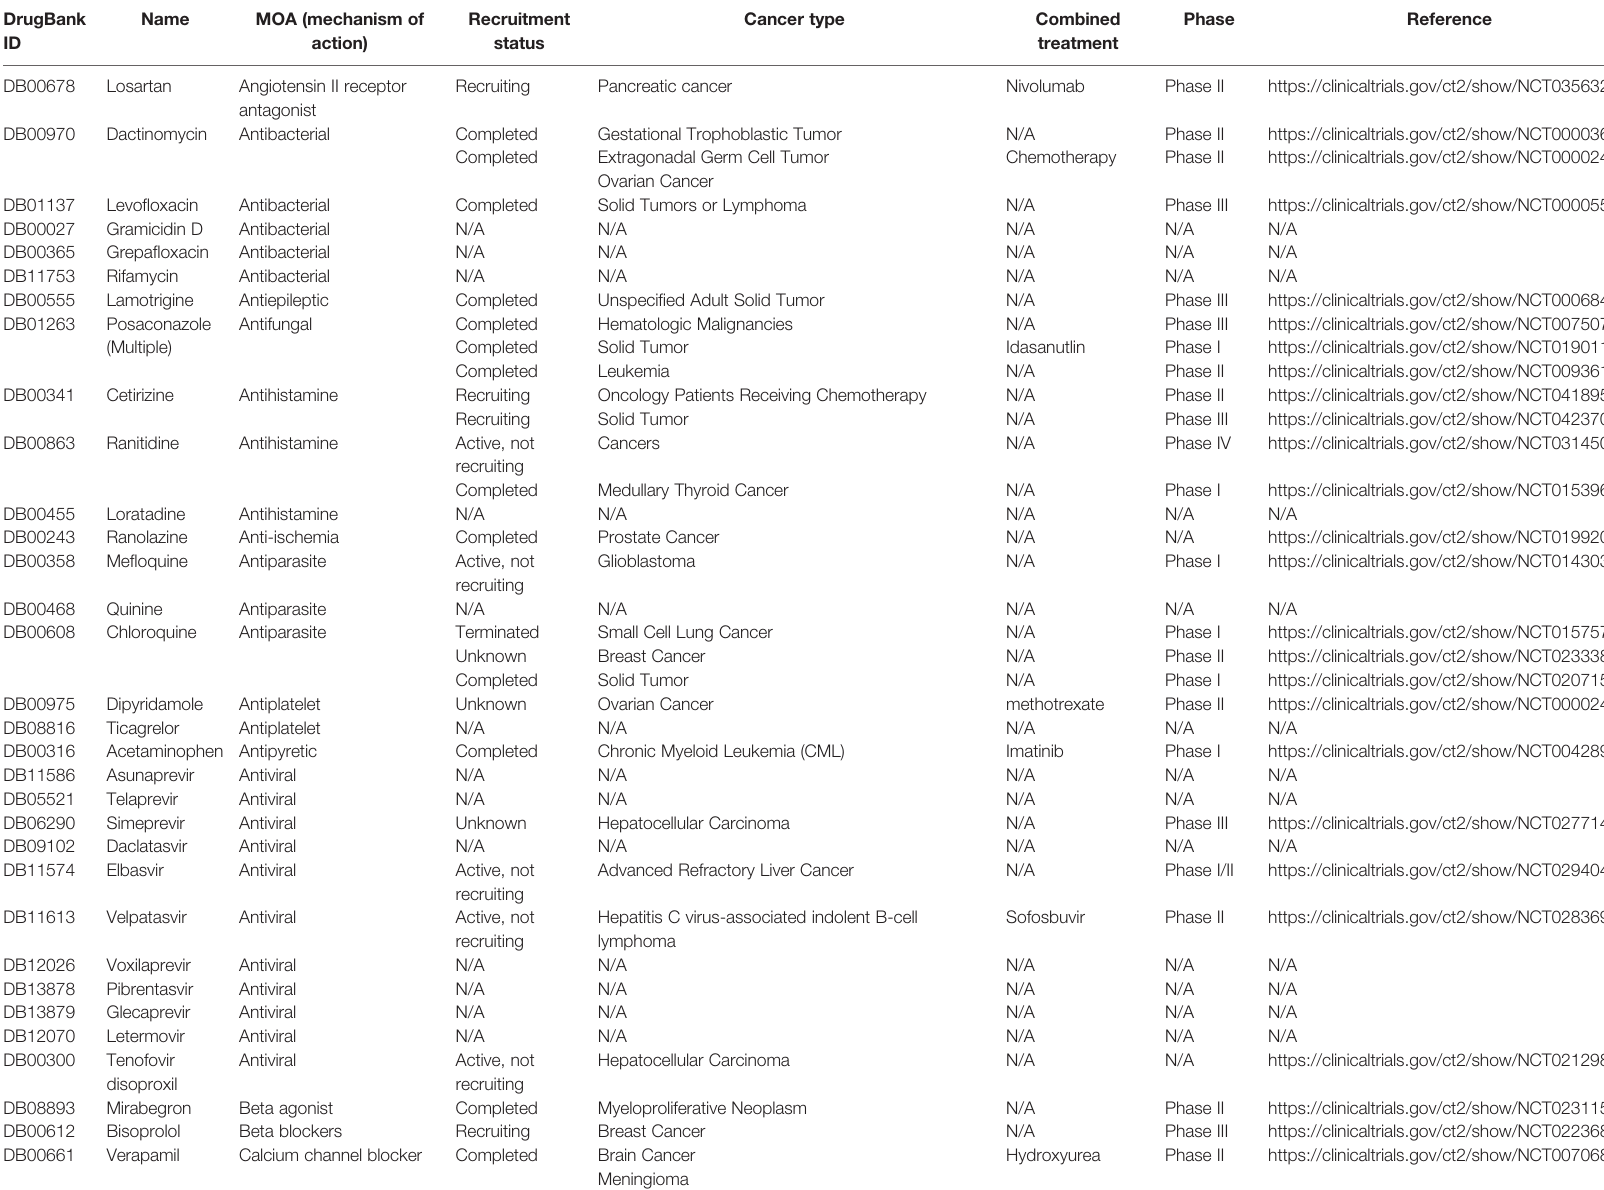
TABLE 1 | FDA approved drugs with p-gp inhibition